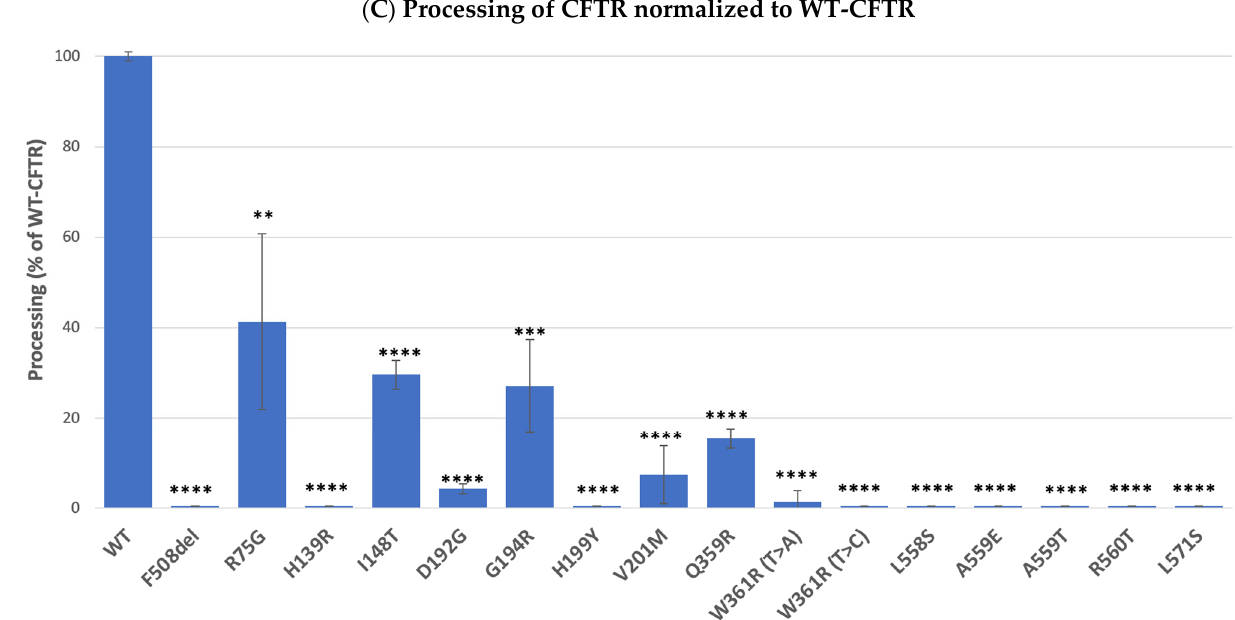
Figure 3. WB analysis of CFBE cells expressing CFTR variants after incubation with 0.1% DMSO ( v / v ), VX-809 (3 µM), VX-661 (5 µM) alone or in combination with VX-445 (3 µM) for 48 h. ( A ) TMD1 variants R75G-, H139R-, I148T-, D192G-, G194R-, H199Y, V201M-, Q359R-, W361R (T > A), W361R (T > C)-CFTR. ( B ) NBD1 variants L558S-, A559E-, A559T-, R560T- and L571S-CFTR. WT-CFTR control is shown close to V201M-CFTR. For each condition, densitometry was used to calculate the percentage of mature CFTR (Band C/Band B + Band C). Data are shown as mean ± SEM. Asterisks indicate significant differences compared with DMSO ( p -value < 0.05, unpaired t -test). Images were acquired using ChemiDoc XRS+ imaging system BIO-RAD and further processed by Image Lab 6.0.1 software. ( C ) Processing of CFTR variants normalized to WT-CFTR. Asterisks indicate significant differences compared to WT-CFTR. * p -value < 0.05; ** p -value < 0.01; *** p -value < 0.001; **** p -value < 0.0001 (two-tailed unpaired Student’s t -test).